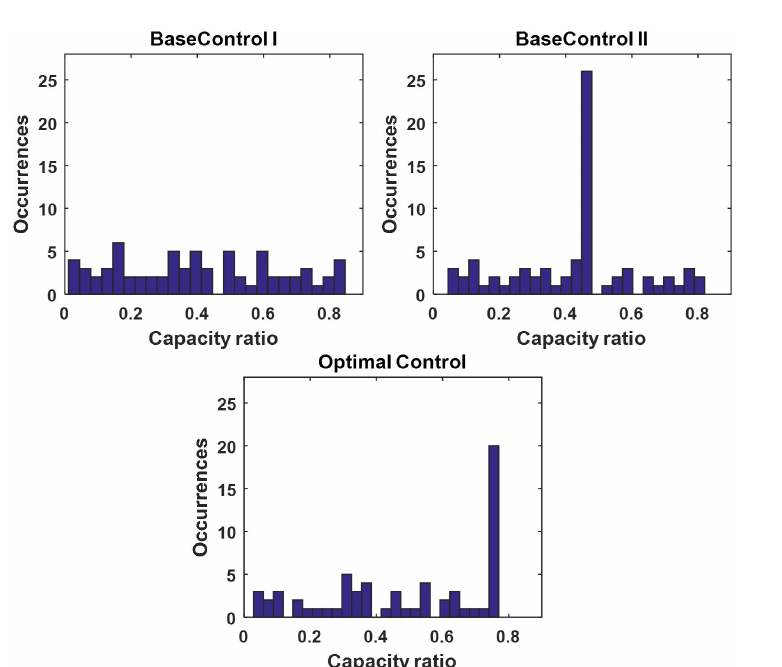
Figure 10. Histograms of the load ratio associated with the different control